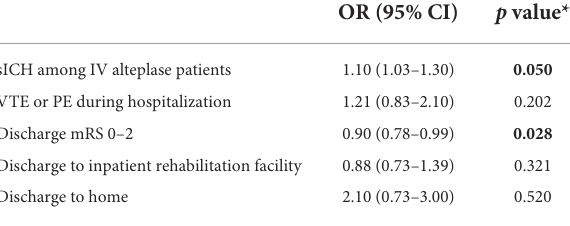
TABLE 5 Association of the COVID-19 pandemic with outcomes among patients with